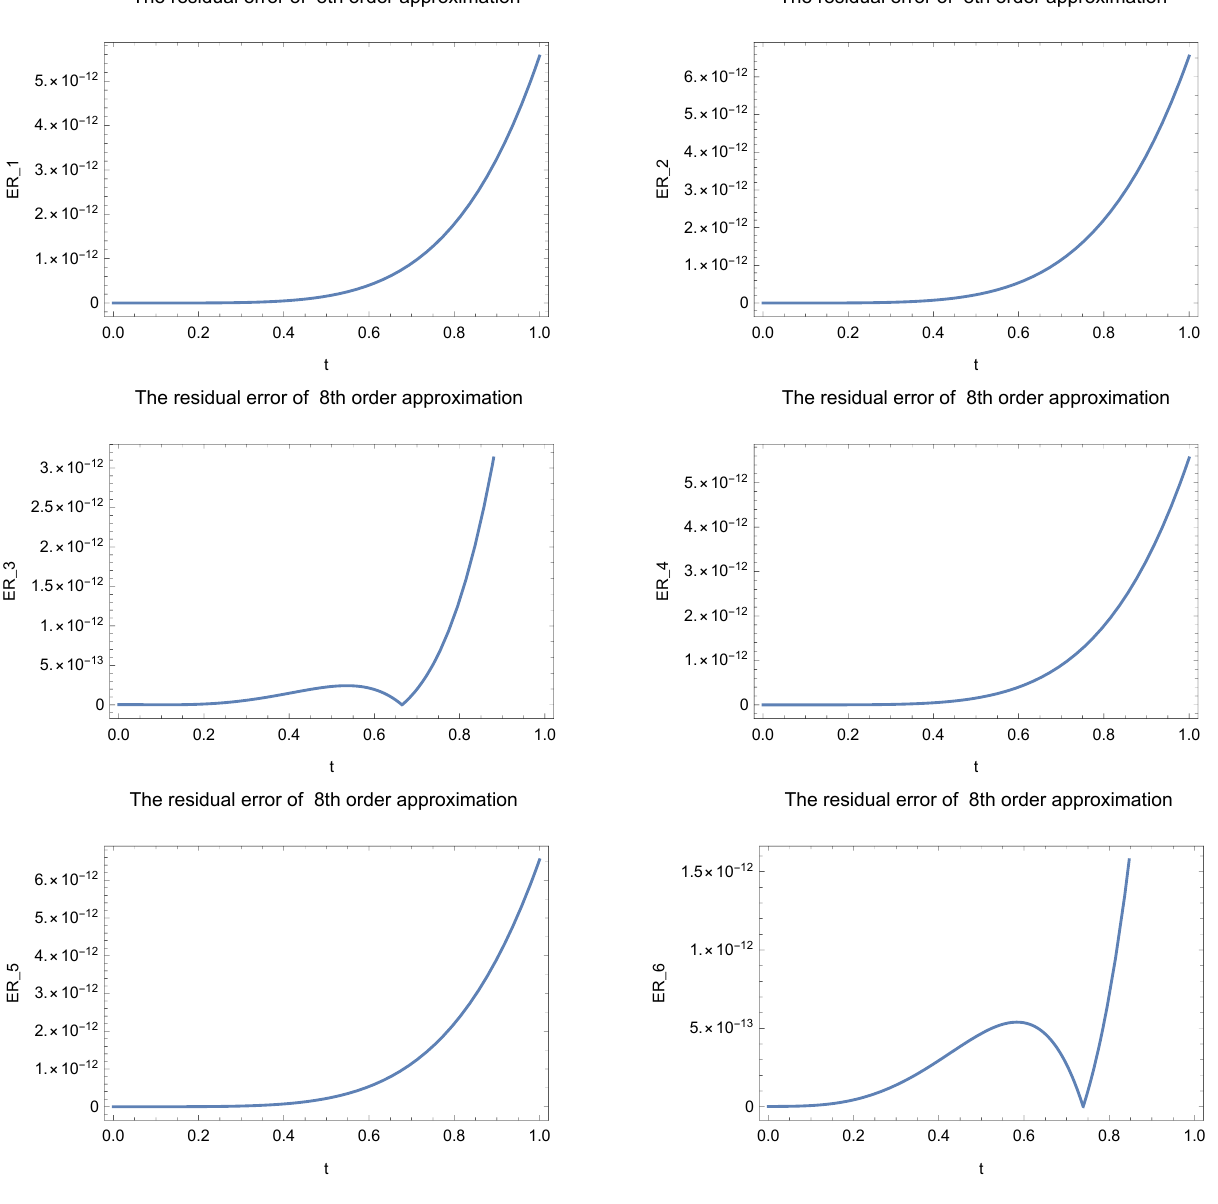
Figure 2. The residual error of 8th order approximation for ER 1 , ER 2 , ER 3 , ER 4 , ER 5 and ER 6 Fig. 2 The residual error of 8 th order approximation for ER 1 , ER 2 , ER 3 , ER 4 , ER 5 and ER 6